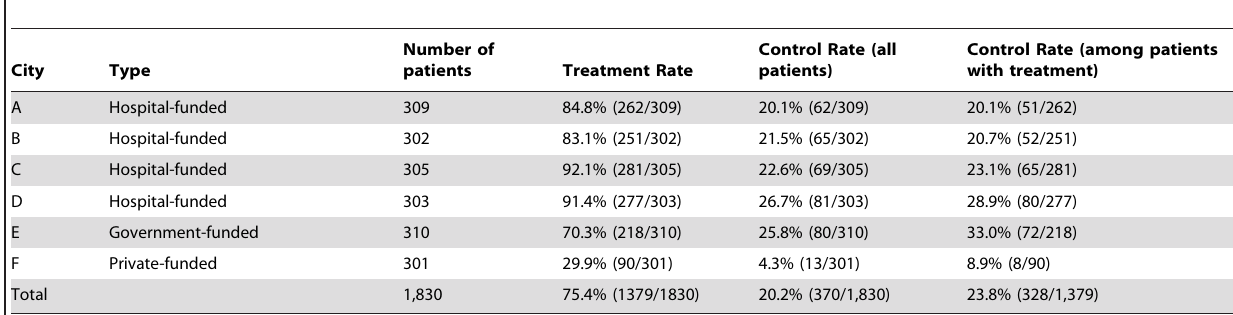
A to F represent selected community health centres in the six cities of the Pearl River Delta region. Treatment was defined as the prescription of at least one antihypertensive agent; control was defined as systolic blood pressure , 140 mmHg and diastolic blood pressure , 90 mmHg; or , 130 mmHg and , 80 mmHg, respectively in patients with diabetes mellitus.